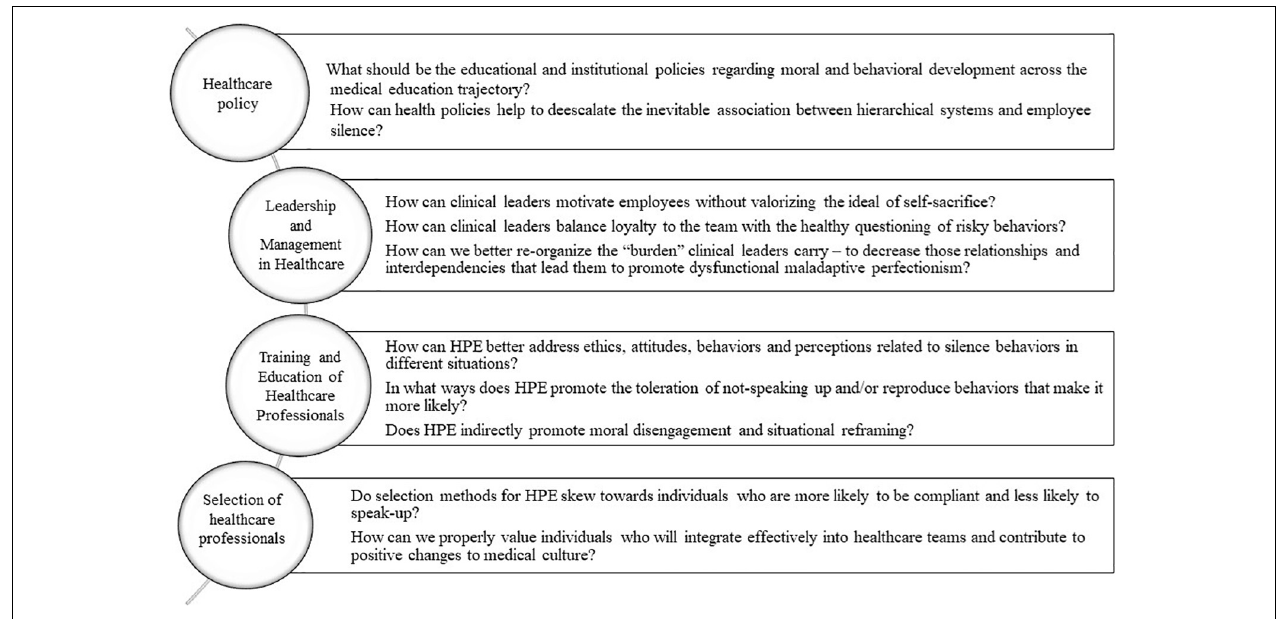
FIGURE 2 | Research agenda for addressing silence in health professionals education